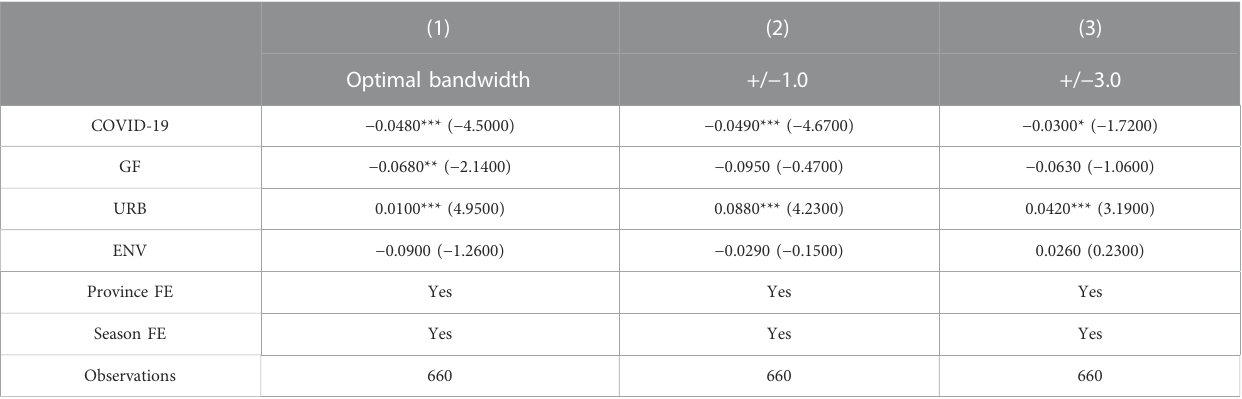
TABLE 5 Robustness test